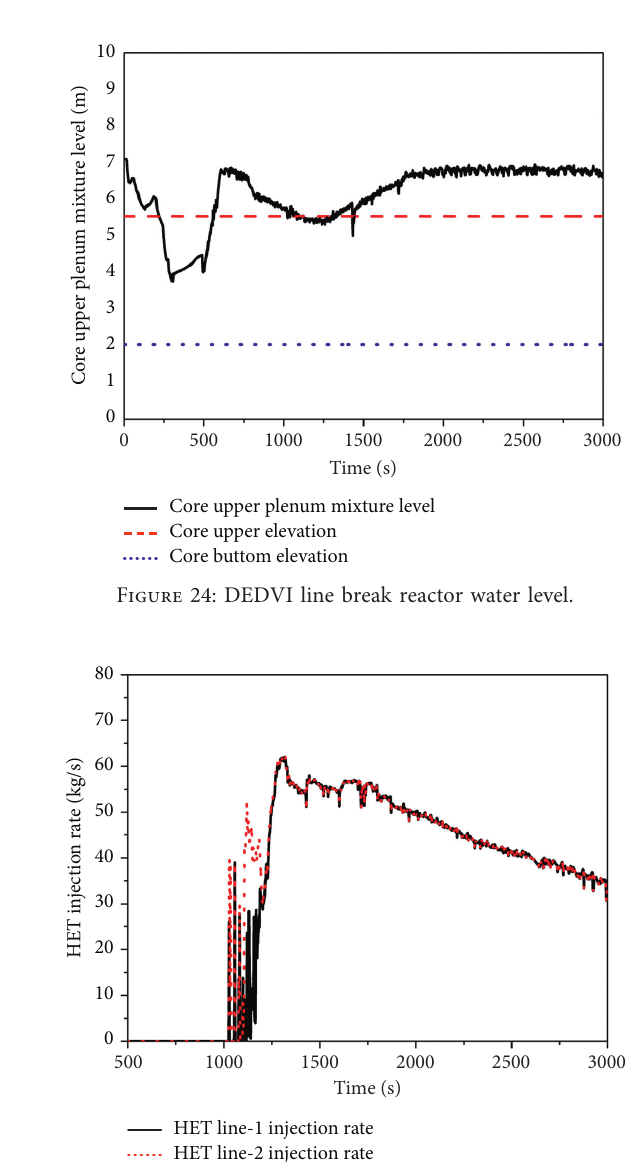
Figure 25: DEDVI line break HET injection rate.